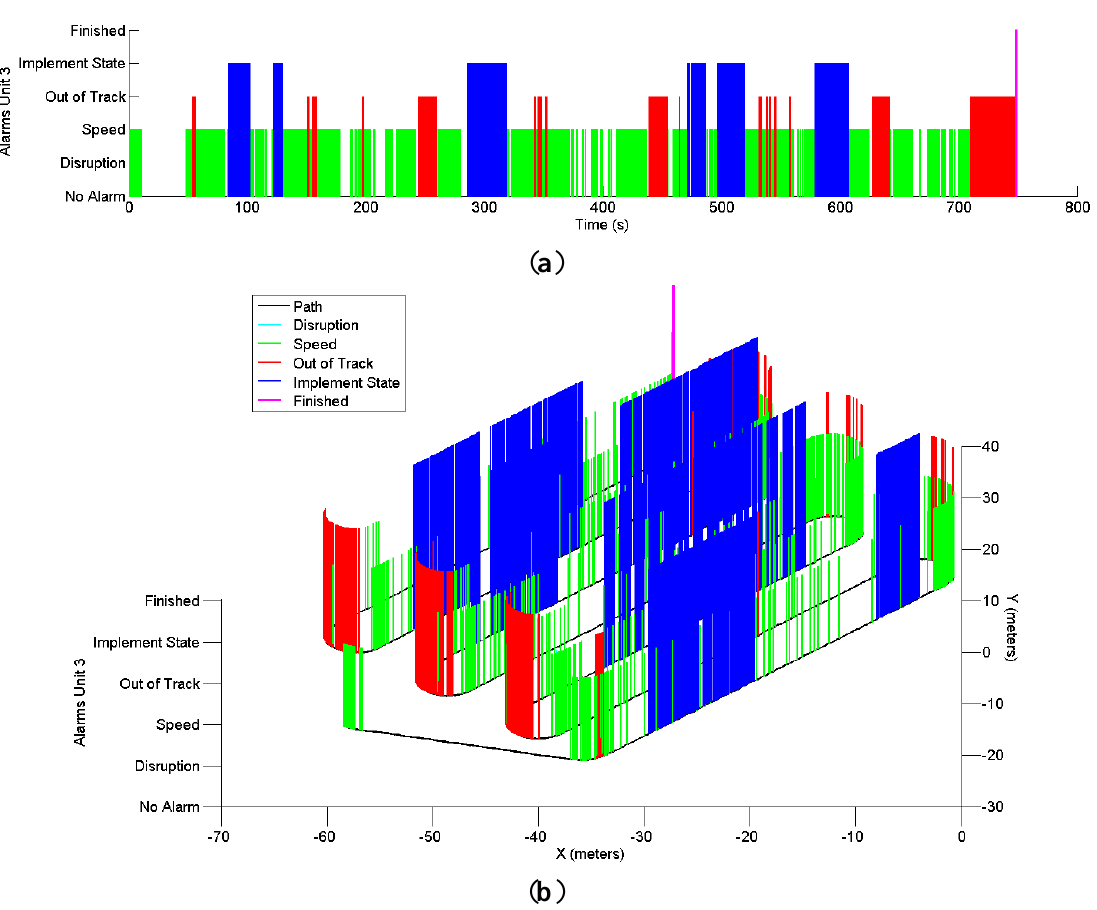
Figure 12. Alarms generated by the unit supervisor ( a ) over time and ( b ) over the